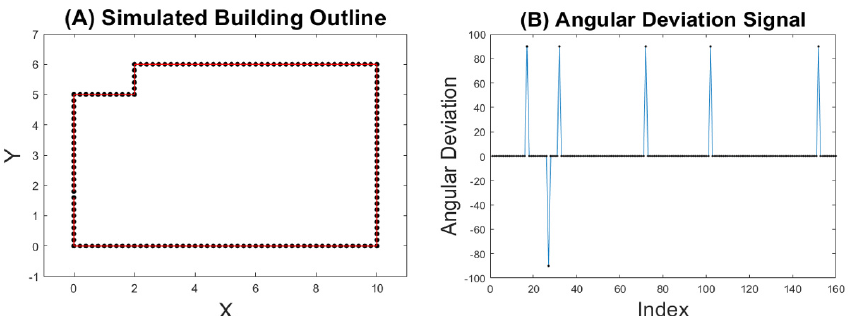
Figure 6. Simulated building outline and corresponding angular deviation signal. ( A ) The simulated building outline that contains no zig-zag shape; ( B ) The corresponding angular deviation signal.